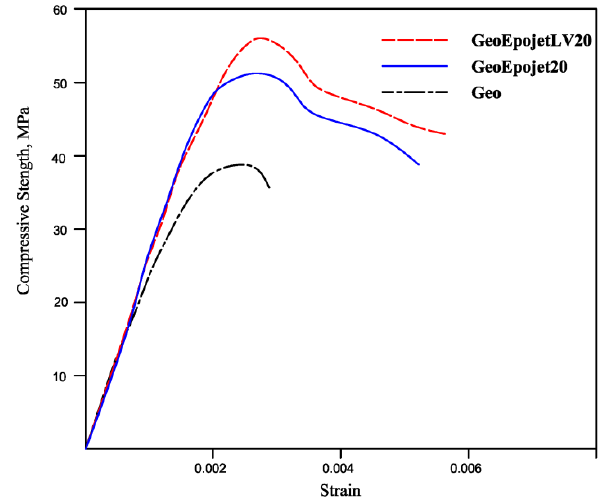
Figure 11. Stress-strain curves of the geopolymer, GeoEpojet20 and GeoEpojetLV20 specimens.